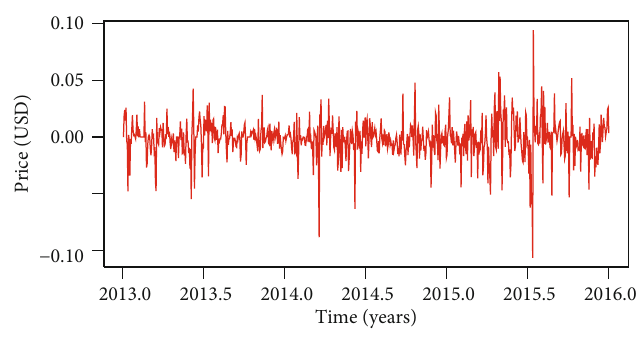
Figure 3: Series of daily returns of steel price. Table 1: NAR-EKF parameter settings.